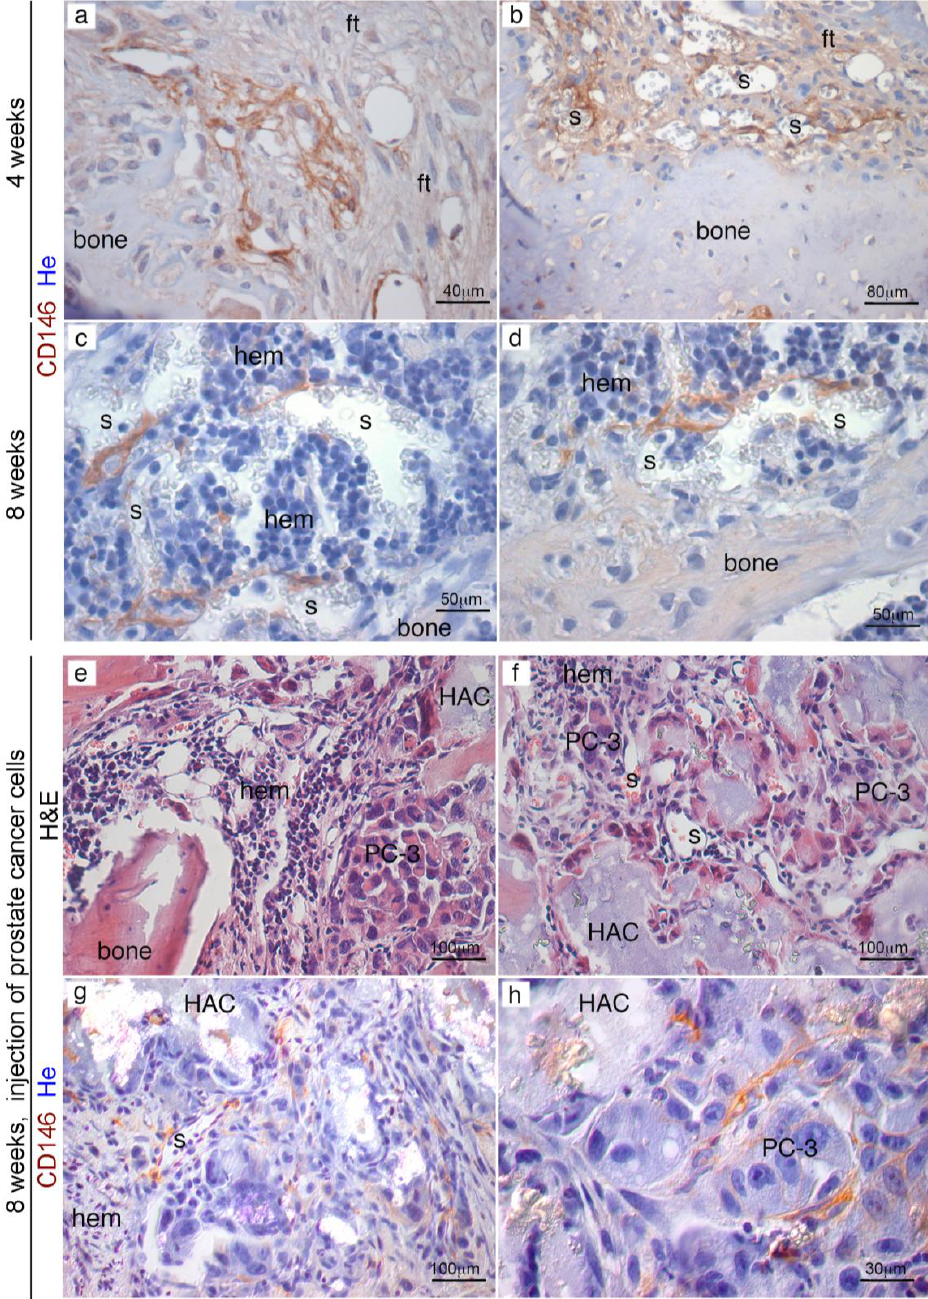
Figure 5. PC-3 cell injection at di ff erent times during heterotopic humanized bone / marrow organ development. About four weeks from of hBMSCs transplantation, extraskeletal ossicles present abundant bone and fibrous tissue, bone but not marrow ( a ). CD146 + cells are mixed with fibrous cells and are in contact with vessels ( b ). About eight weeks from transplantation, a complete marrow microenvironment has been recreated in extraskeletal ossicle and CD146 + can be detected as pericytes around BM sinusoids ( c , d ). Injection of PC3 cells four weeks after hBMSCs transplantation resulted in unsuccessful migration / survival of human cancer cells in heterotopic ossicles ( e , f ). PC3 cells injected eight weeks from hBMSCs transplants were able to grow in ectopic humanized BM ossicles. Immunolabelling for human CD146 identified both metastatic foci of PC3 cells ( h ) and the human advential reticular cells wrapped around the sinusoid wall ( g ). H&E, Hematoxylin / Eosin; ft, fibrous tissue; s, sinusoid; hem, hematopoiesis, HA, hydroxyapatite. He, Hematoxylin counterstaining. Scale bar = 30, 40, 50, 80, 100 µ